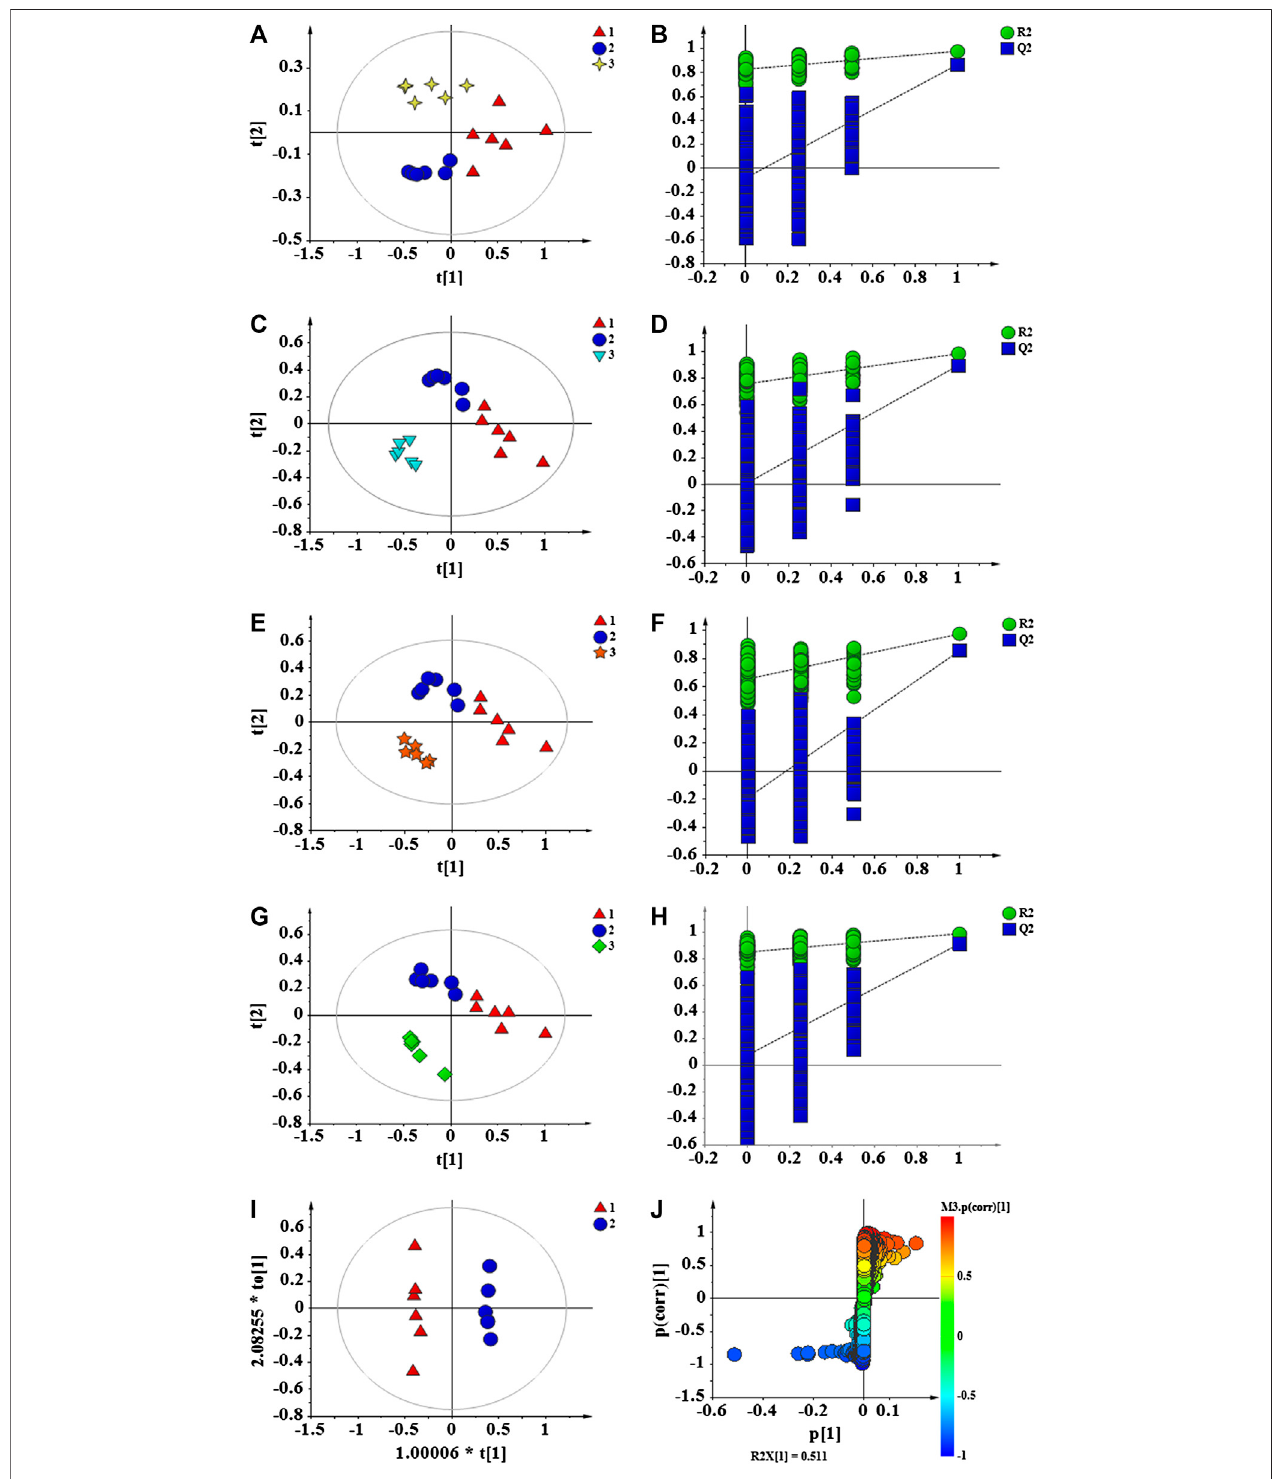
FIGURE 8 | PLS-DA score plots of C, M and APS (A) ; permutation test of C, M and APS (B) ; PLS-DA score plots of C, M and APS-I (C) ; permutation test of C, M and APS-I (D) ;PLS-DAscoreplotsofC,Mand APS-II (E) ;permutationtest ofC,Mand APS-II (F) ;PLS-DAscoreplotsofC,Mand APS-III (G) ;permutationtestofC,M and APS-III (H) ; OPLS-DA score plots of C and M ( I ) ; S-plot of C and M (J) . C: Control group, M: Model group. 1 (Triangle) (cid:2) M, 2 (circle) (cid:2) C, 3 (4-plot star) (cid:2) APS, 3 (inverted triangle) (cid:2) APS-I, 3 (5-plot star) (cid:2) APS-II, 3(diamond) (cid:2) APS-III.